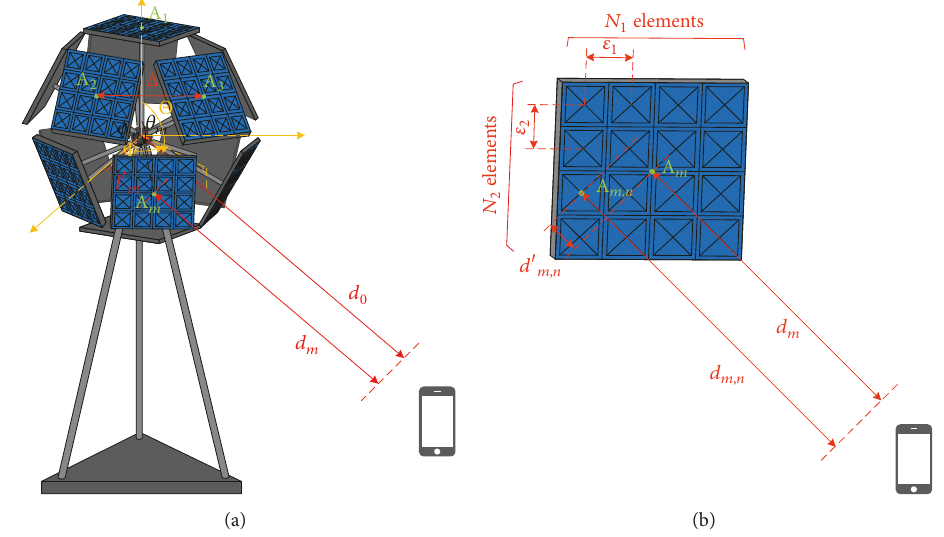
Figure 2: Antenna structure and parameters: (a) 12 subarrays and (b) single subarray.